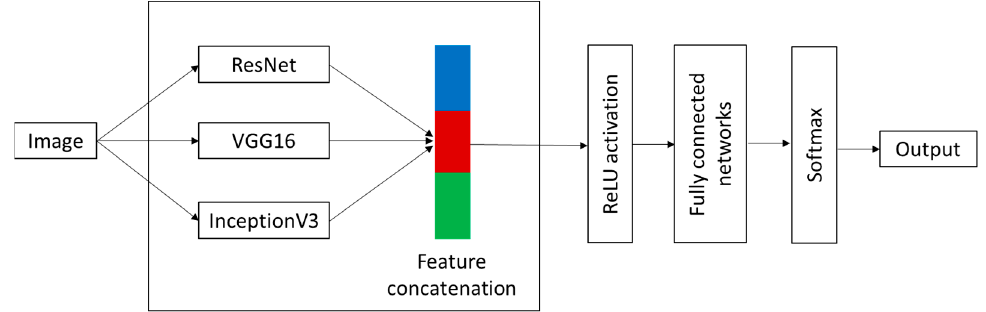
Figure 2. The multimodal data fusion of the deep learning framework.